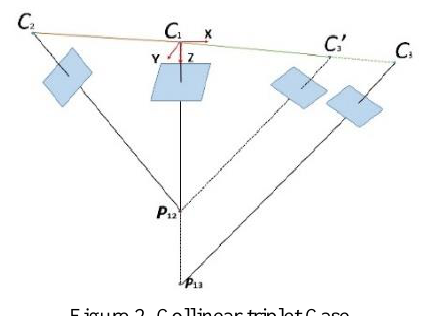
Figure 2. Collinear triplet